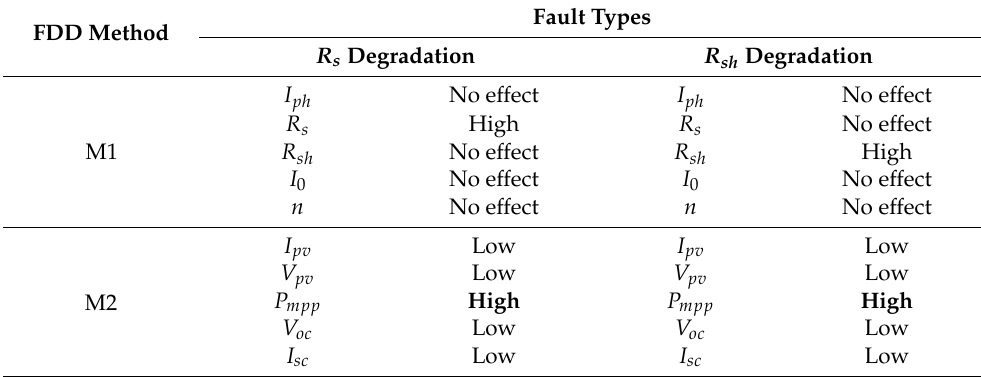
Table 20. Summary of FDD